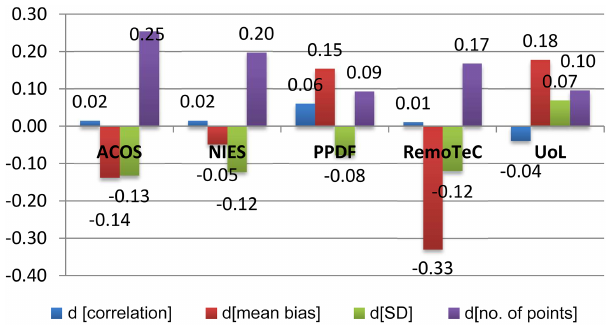
Figure 7. Difference (denoted as d [] ) in correlation coefficients, mean bias (ppm), SD (ppm) and number of observational points between methods C4 (the collocation domain size is determined by sensitivity values (ppm(µmol(m 2 s) − 1 ) − 1 ) with the limit of log 10 ( x ) equal to − 2.0) and C8 (the collocation domain size is rectangular with dimension ± 7.5 ◦ ×± 22.5 ◦ ) using ACOS, NIES, PPDF, RemoTeC and UoL GOSAT products near the Darwin site. Please note that the scale of number of observational points is 10 5